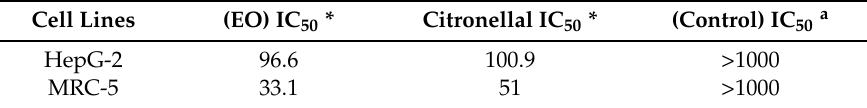
Table 5. Cytotoxic activity of the essential oil of C. nardus (EO) and